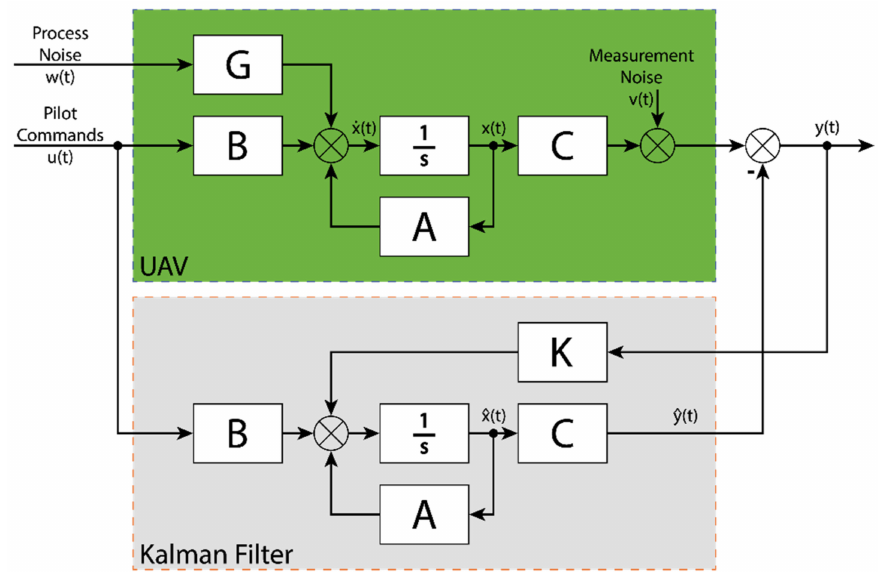
Figure 6. Block diagram of Kalman filter.